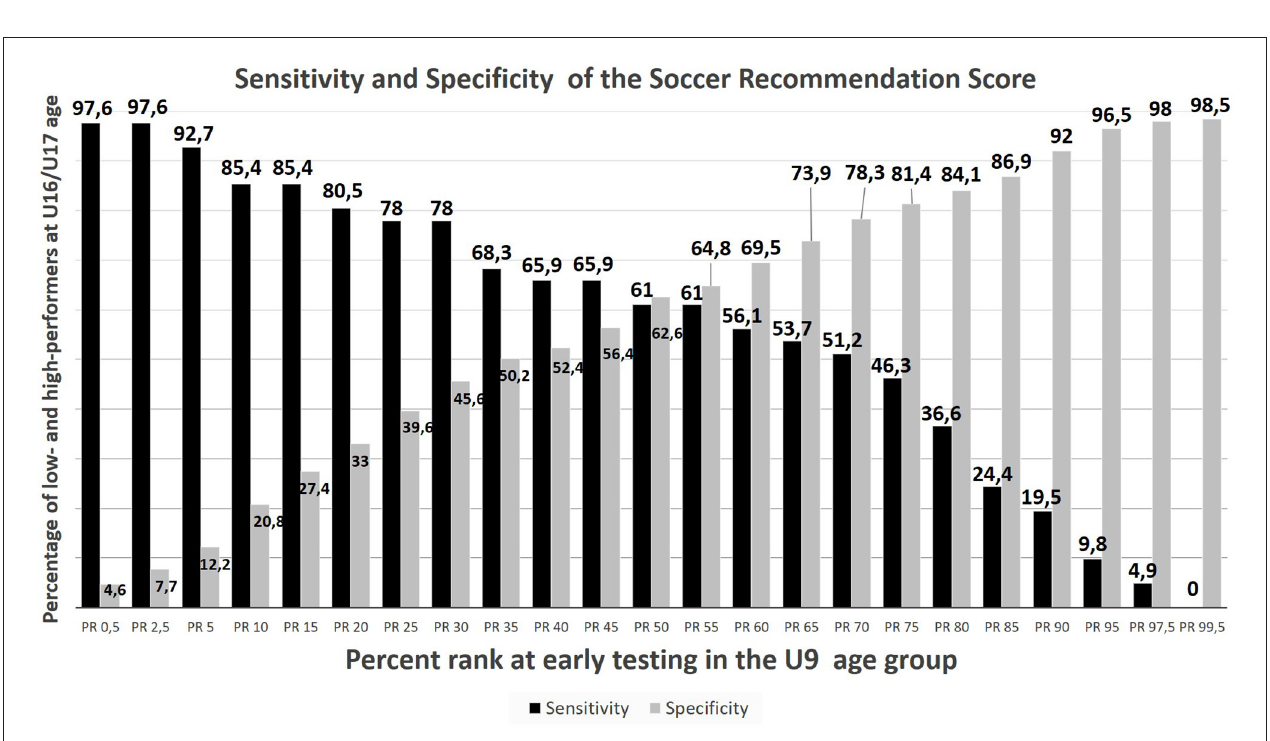
FIGURE 7 | Specificity and sensitivity of the soccer recommendation score (SRS) of the U9 participants to predict a future soccer performance on the highest provincial level (level 5) at adolescence (U17).